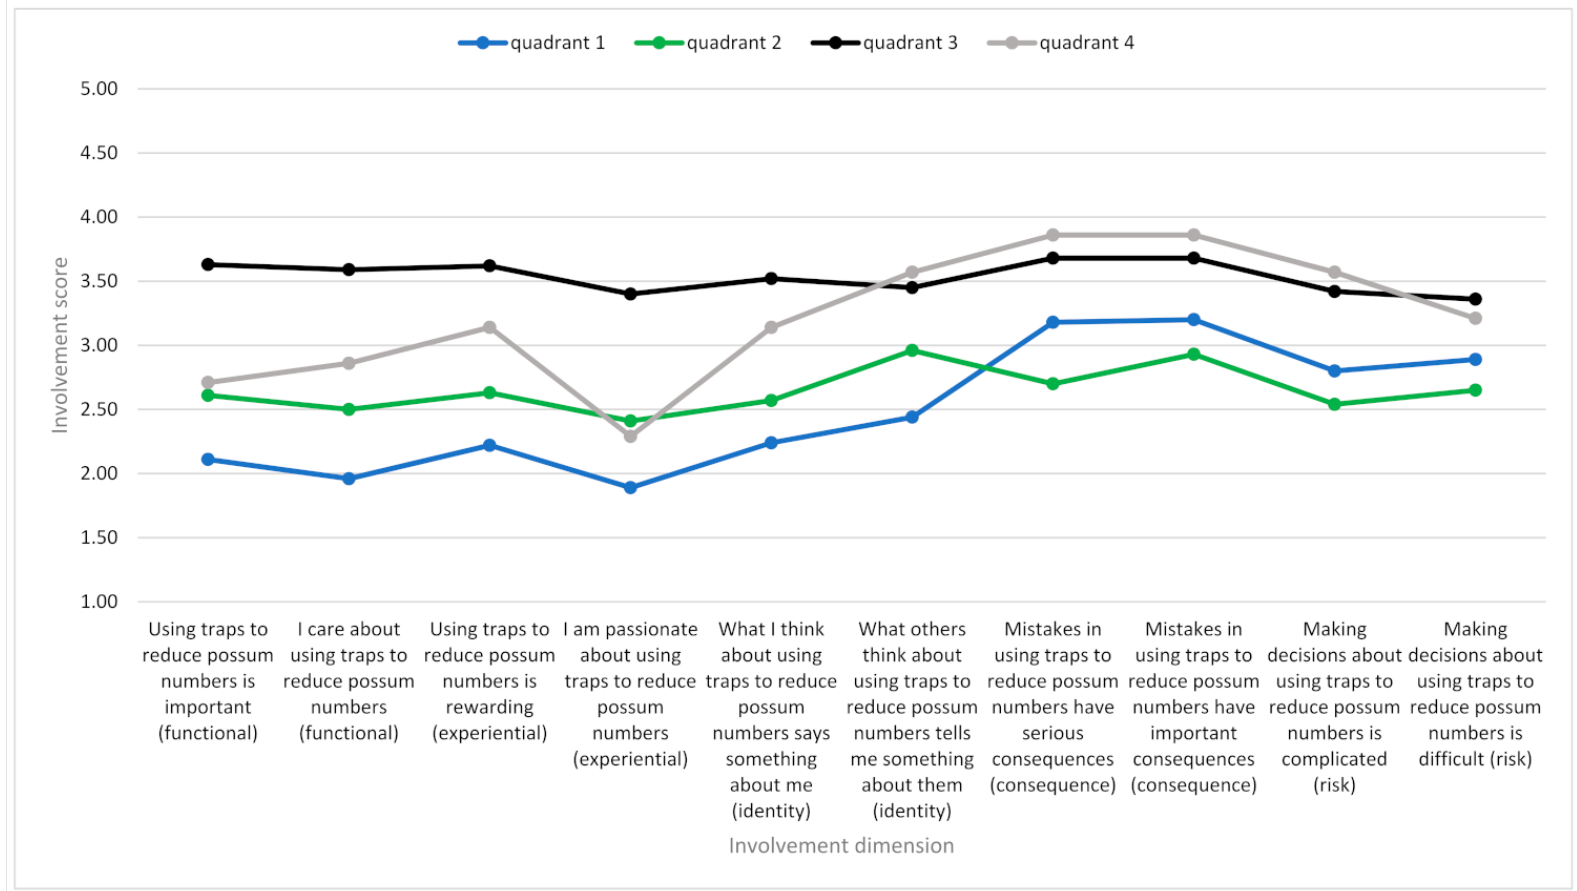
Figure 4. Involvement profiles for the idea of using traps to reduce possum